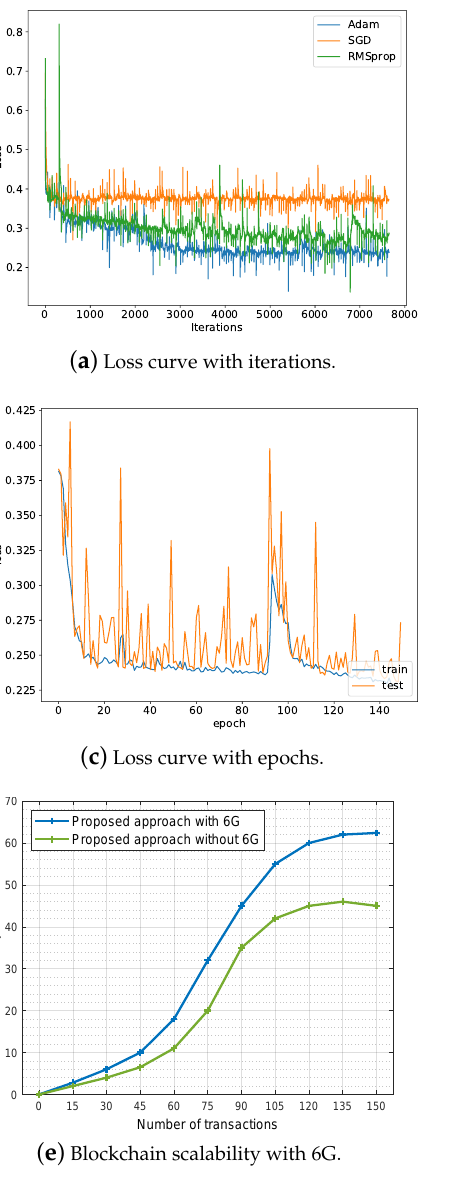
( b ) Accuracy curve with iterations.